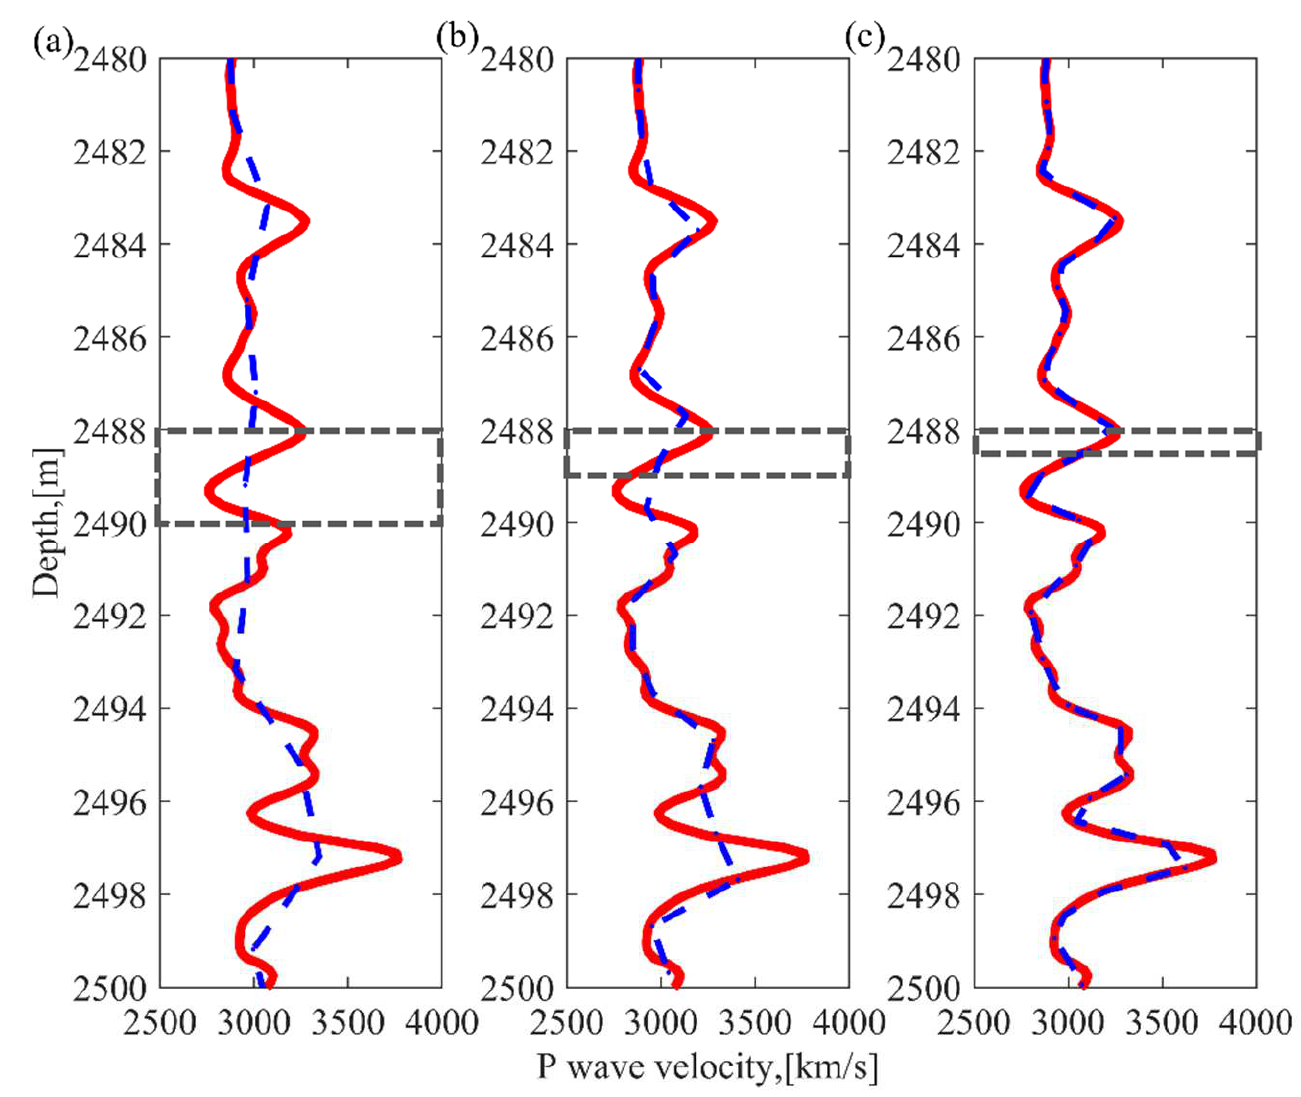
Figure 5. P_wave velocity calculated by using the Backus averaging method. The red solid curve is the real data, and the blue dash curve is the result from the Backus averaging method. ( a ) 16 samples in a window, ( b ) 8 samples in a window, ( c ) 4 sample in a window.